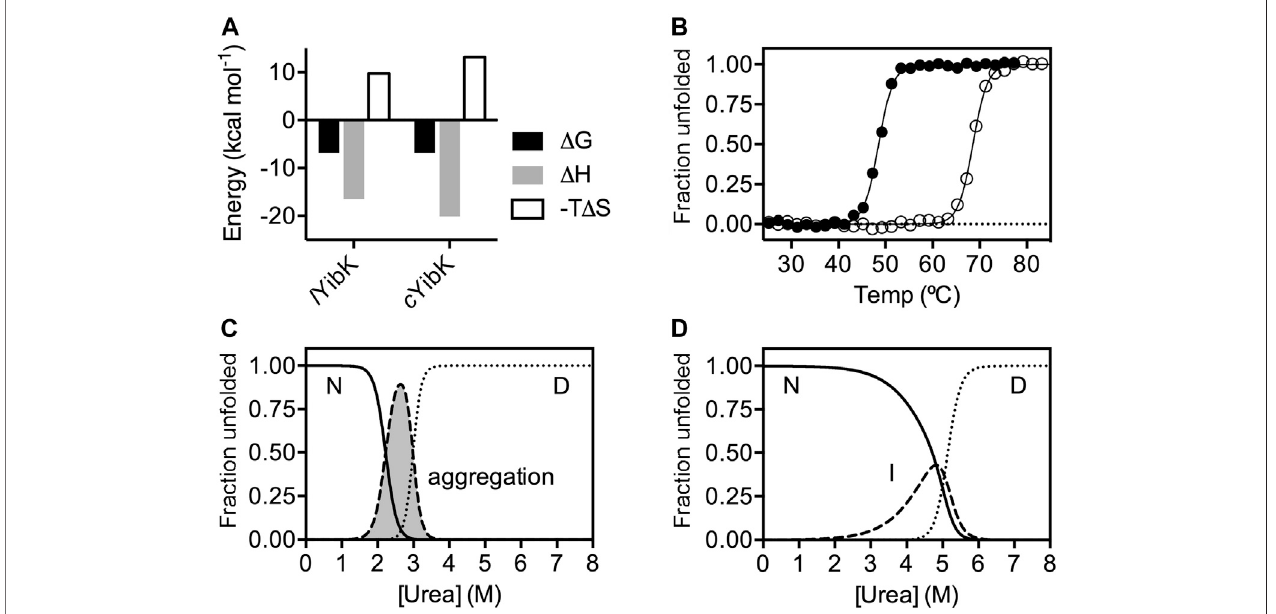
FIGURE 2 | The impacts of cyclization on SAH binding and chemical stability of YibK. (A) Thermodynamics parameters associated with SAH binding derived from ITC analyses. (B) Normalized fractional unfolded populations of l YibK ( fi lled circles) and c YibK (open circles) derived from thermal denaturation monitored by far-UV CD spectroscopy. Intrinsic fl uorescence-derived normalized fractional populations of native (N), intermediate (I) and denatured (D) states of l YibK (C) and c YibK (D) as a function of urea concentration. For l YibK, fl uorescence signal loss due to aggregation was observed and the corresponding population is shaded in gray and